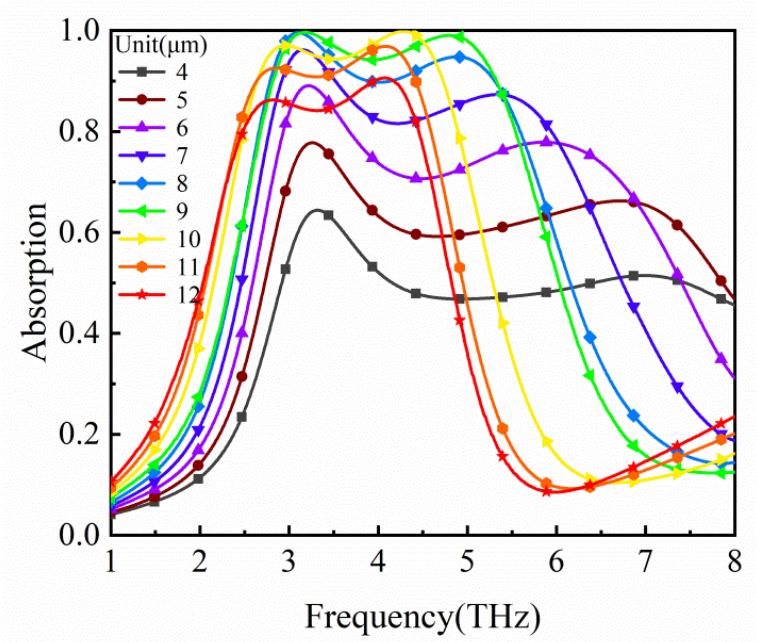
Figure 6. Absorption spectra of the absorber for different dielectric layer thicknesses.